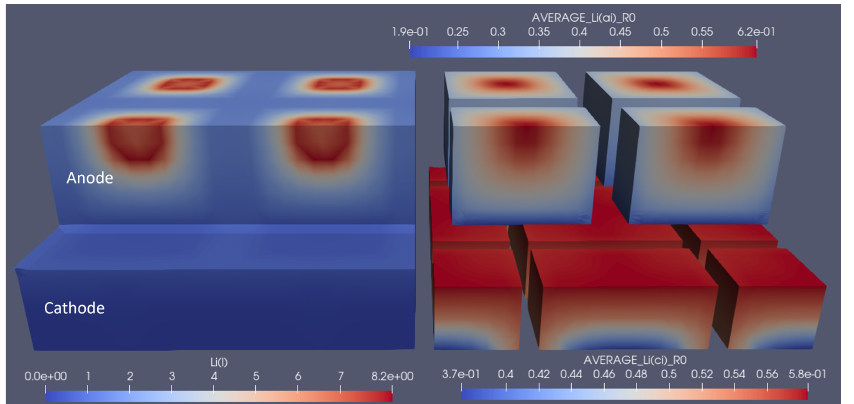
Figure 7. Snapshot of the lithium-ion concentrations in electrolytes and solids for the optimal grid structuring at the end of the 3C discharge cycle. The left part shows the concentration in the electrolyte, and the right part shows the average particle concentration in the respective electrodes.